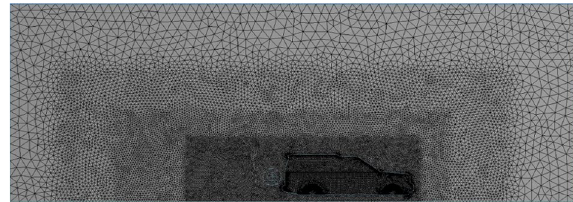
Figure 7. Mesh with three VCBs around the car.